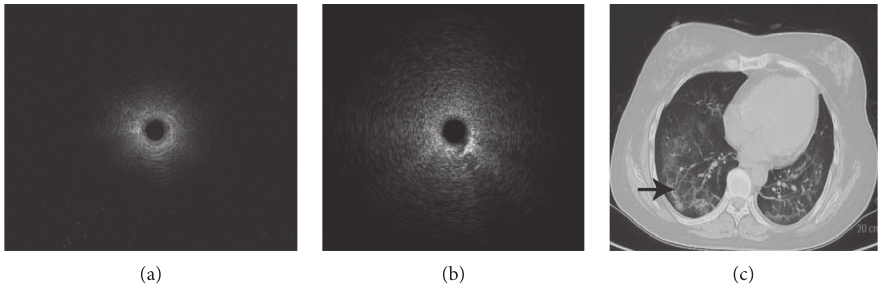
Figure 4: The EBUS image of normal lung parenchyma surrounding bronchial structures had patchy and numerous hyperechoic particles that were typically called snowstorm-like. The image represented normal air-filled alveoli (a), an EBUS image of Pneumocystis carinii pneumonia (PCP). The image was from a 46-year-old woman which demonstrates mixed blizzard sign, the internal echo of the lesions demonstrated diffuse heterogeneity with several hyperechoic dots and linear arcs that were distributed irregularly (b). The CT manifestations included bilateral diffuse ground-glass opacity (c). Biopsy was performed at part-solid GGO lesion in the right lower lung lobe, the diagnosis of pneumocystis carinii infection identified by mNGS ((c) black arrow).